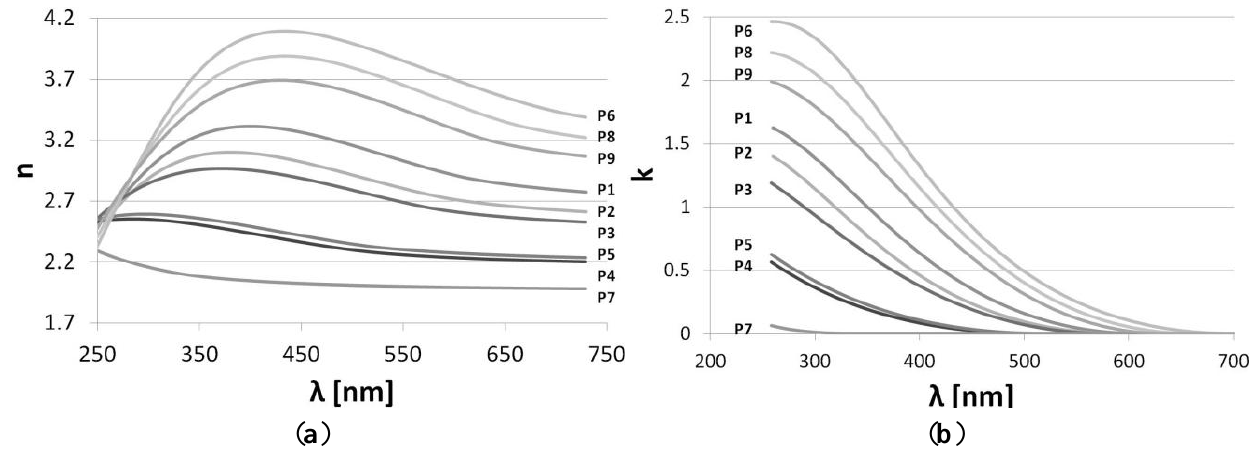
Figure 3. Influence of the deposition process parameters, i.e ., T , f determined according to Table 1, on ( a ) n and ( b ) k of the SiN performed on Si wafers at constant deposition time (5 min) and RF generator power (50